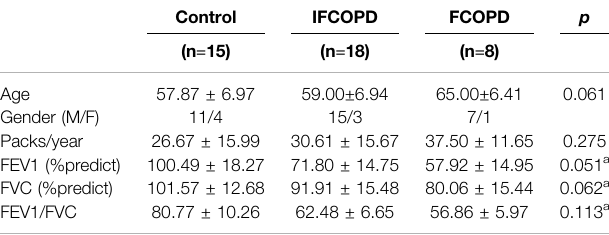
TABLE 2 | Demographic characteristics of